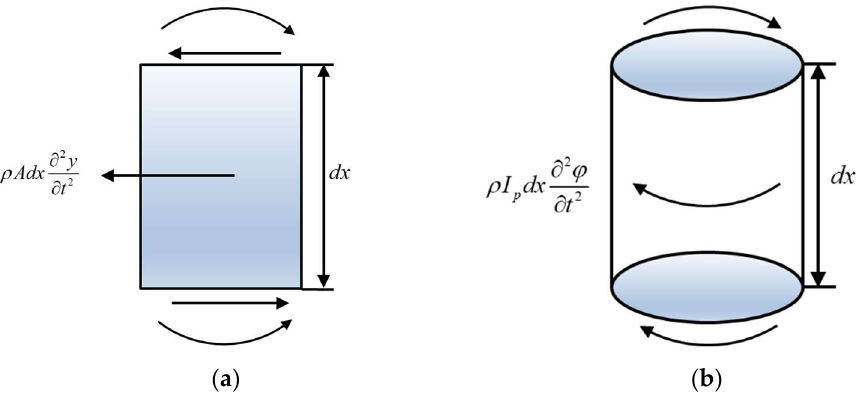
Figure 4. Mechanical analysis of a perforated string element: ( a ) sketch of mechanical analysis under radial shock loads; ( b ) sketch of mechanical analysis under circumferential shock loads.